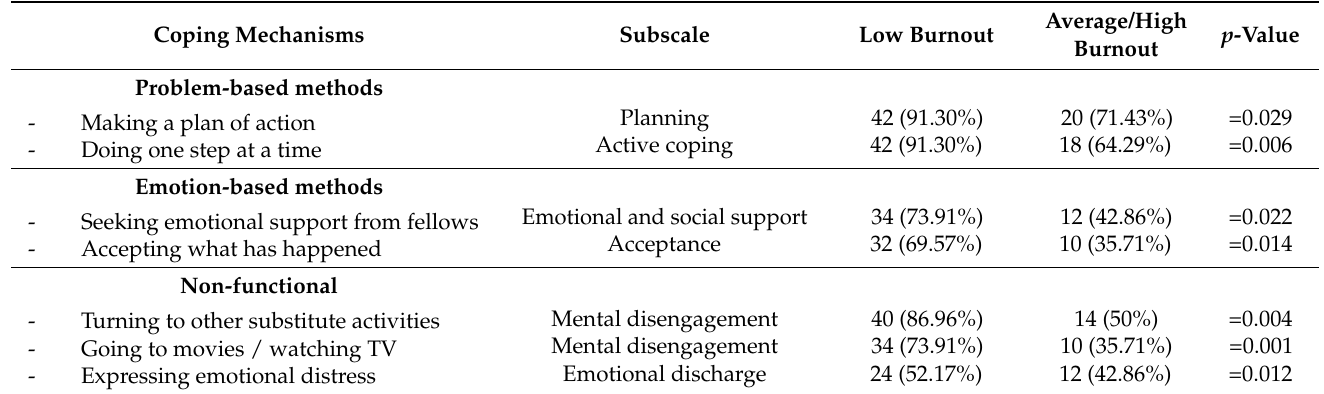
Table 10. Coping